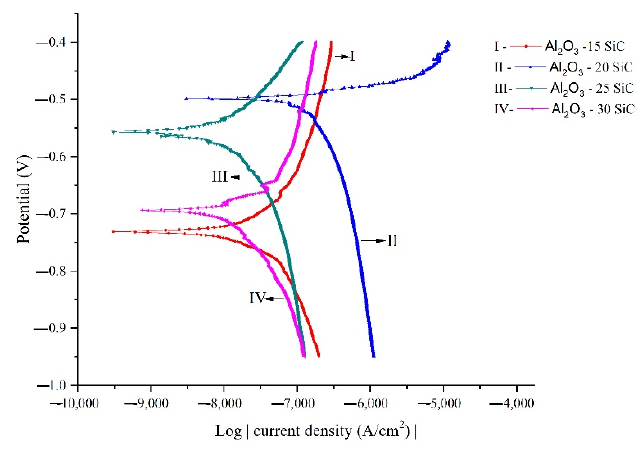
Figure 9. Tafel plots for Al 2 O 3 –SiC composites.